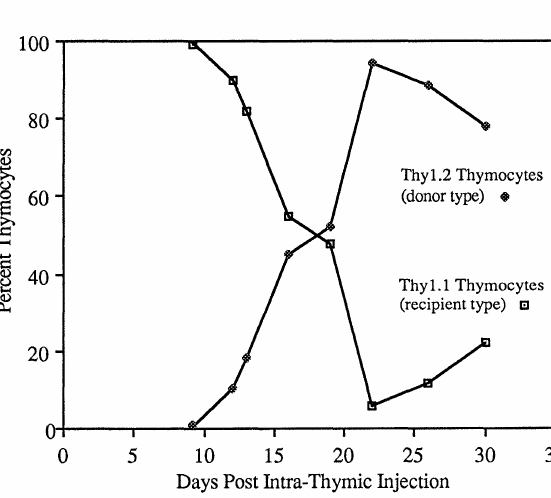
FIGURE 1. The kinetics of appearance of donor-derived Thy- cells after intra-thymic transfer of fetal liver cells. 5 x 105 fetal liver cells prepared from C57BL/Thy1.2 mice were injected intra- thymically into one thymic lobe of sublethally irradiated adult C57BL/Thyl.1 mice. On designated days, the mice were sacri- ficed, both thymic lobes were removed, and the percentage of Thyl.1 cells and Thyl.2 cells determined. The data represent an example of three experiments performed using cells from day- 12